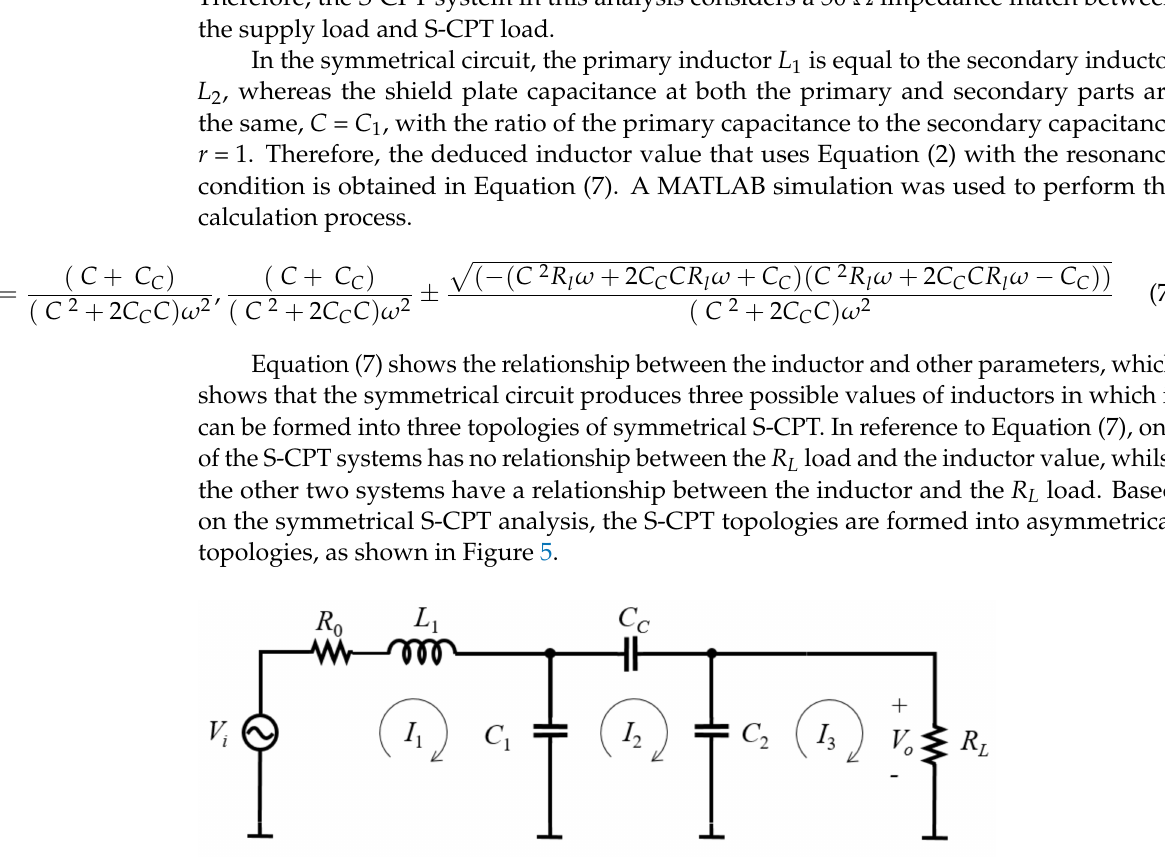
Figure 5. An equivalent of asymmetrical